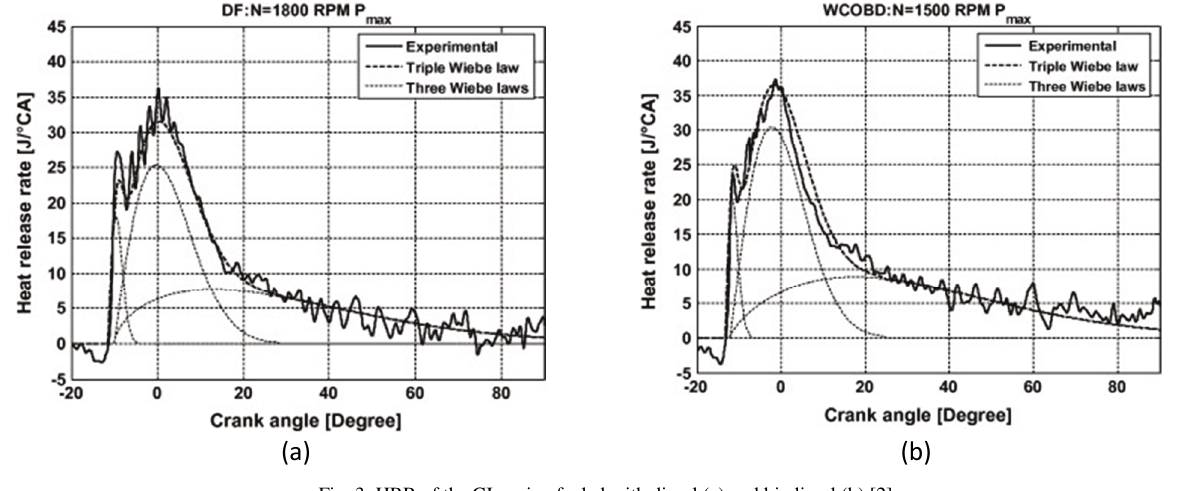
Fig. 3. HRR of the CI engine fueled with diesel (a) and biodiesel (b)